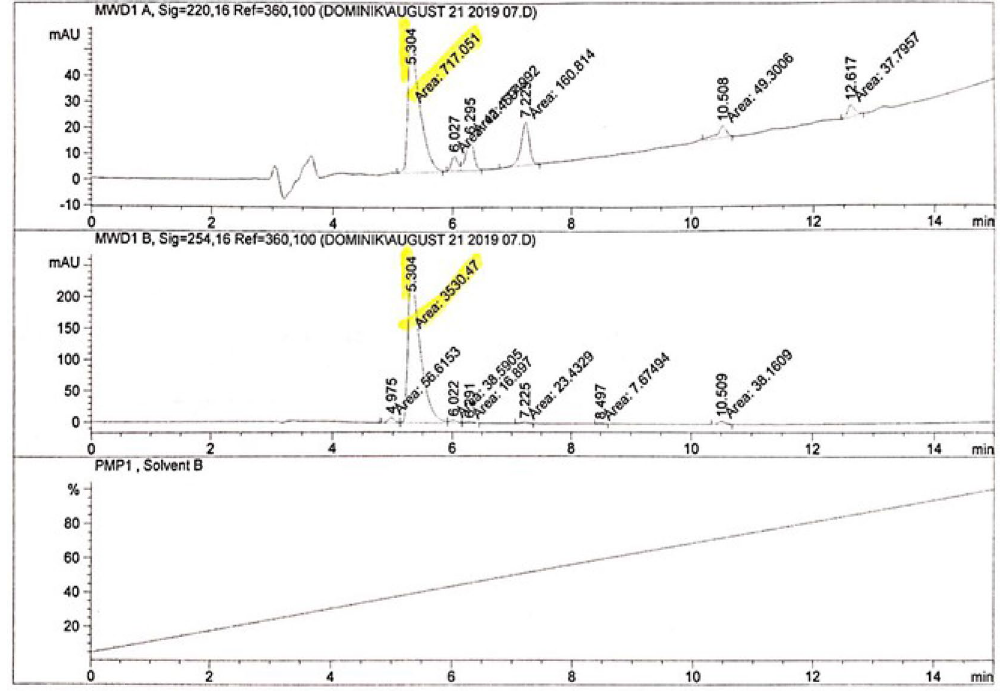
Figure 1. High-pressure liquid chromatography (HPLC) confirms the nicotine content of e-liquid before cell treatment. The graphs represent the composition of chemicals in the e-liquid solution, pure nicotine and methanol (used as control). The mean (± SD) of three determinations relative to nicotine content within the e-liquid was reported to be 0.73 ± 1 mg/mL. (SD = standard deviation). HPLC: high-pressure liquid